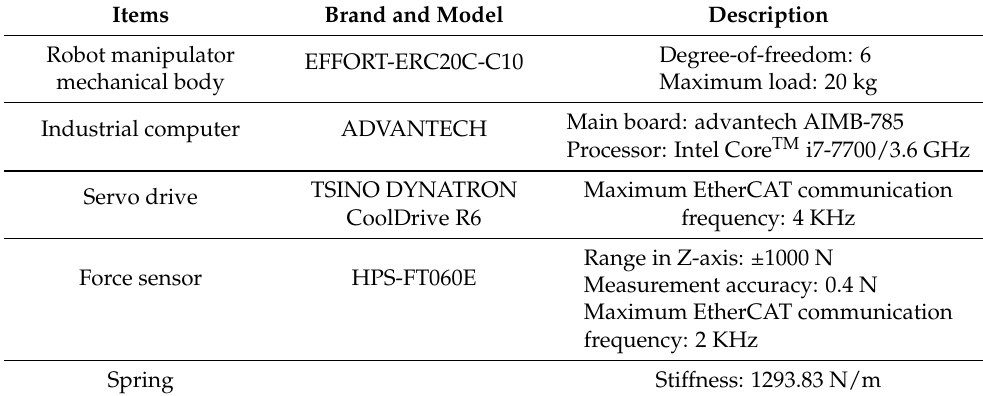
Table 3. Model and description of the experimental platform.